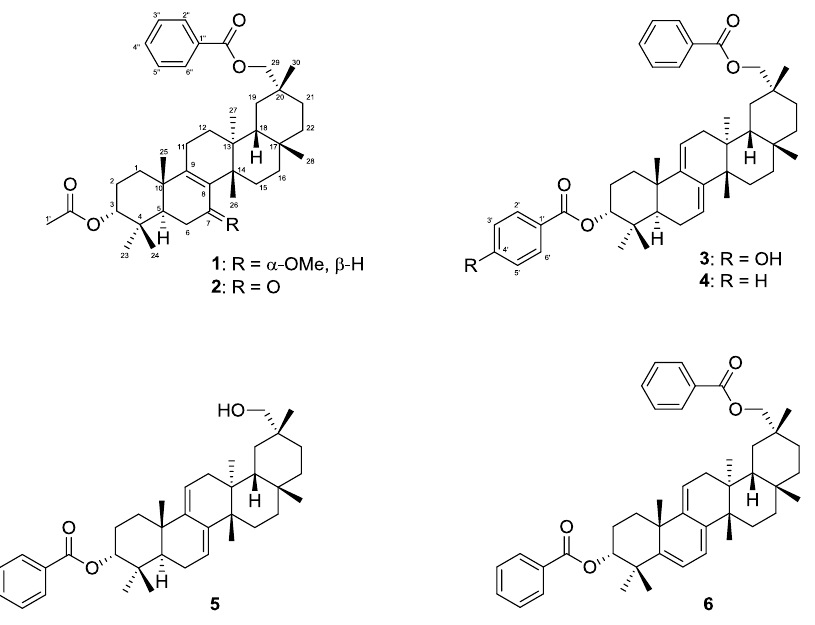
Figure 1. Chemical structures of isolated compounds 1 – 6